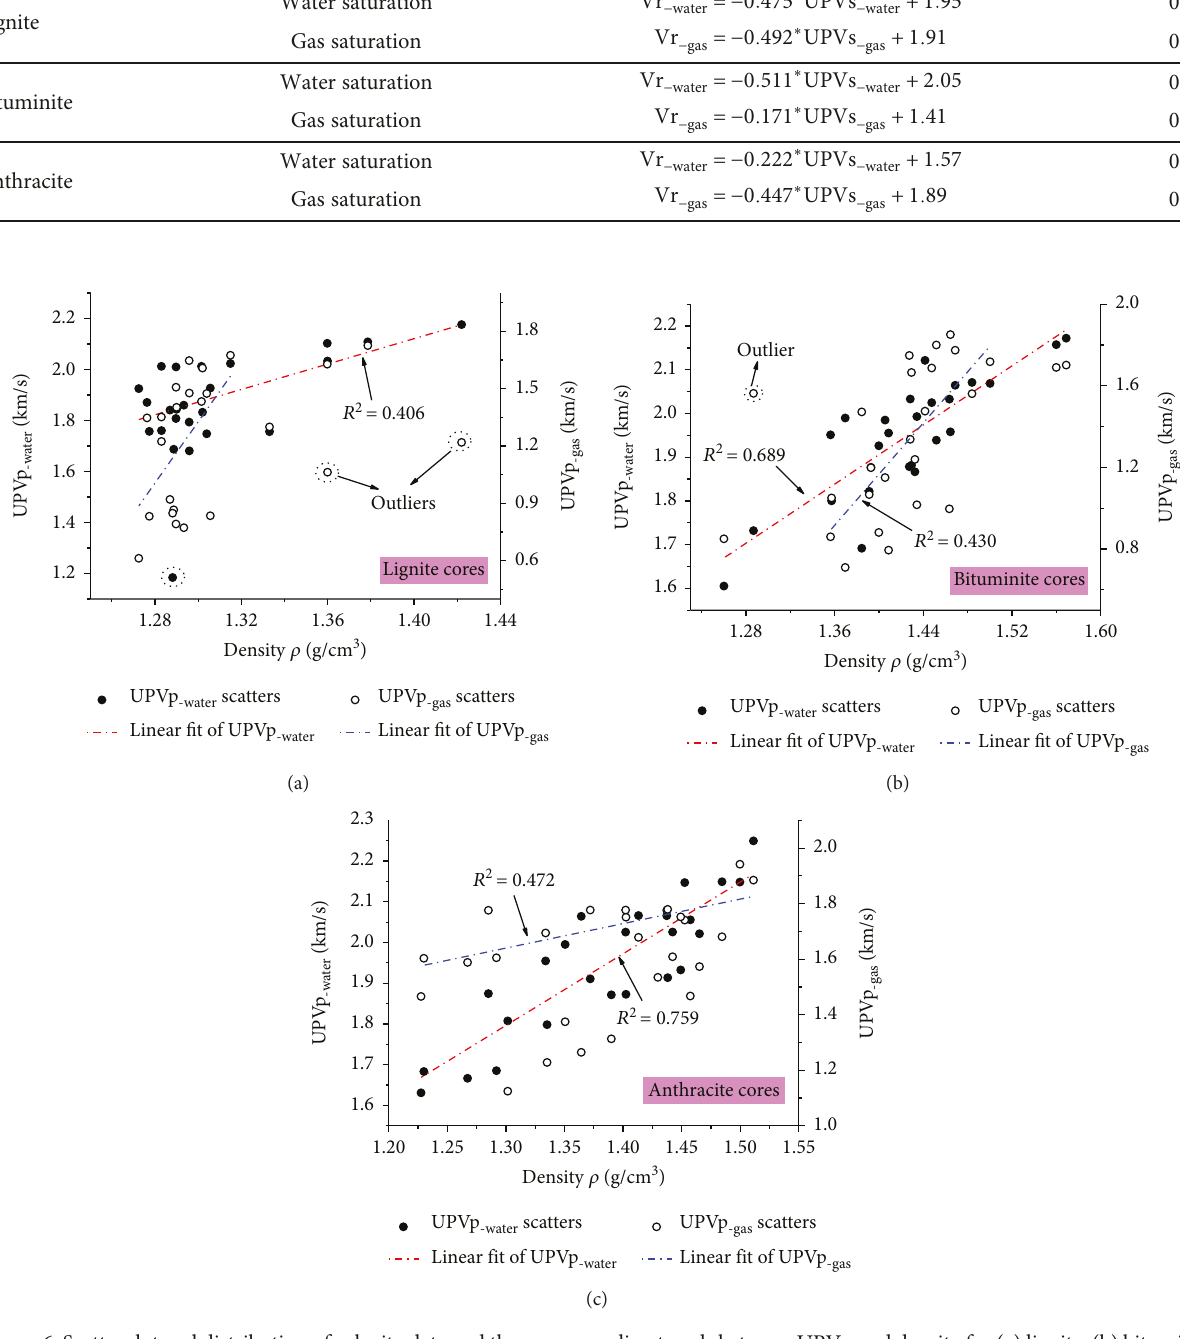
Figure 6: Scatterplot and distribution of velocity data and the corresponding trends between UPVp and density for (a) lignite, (b) bituminite, and (c) anthracite at water/gas-saturated